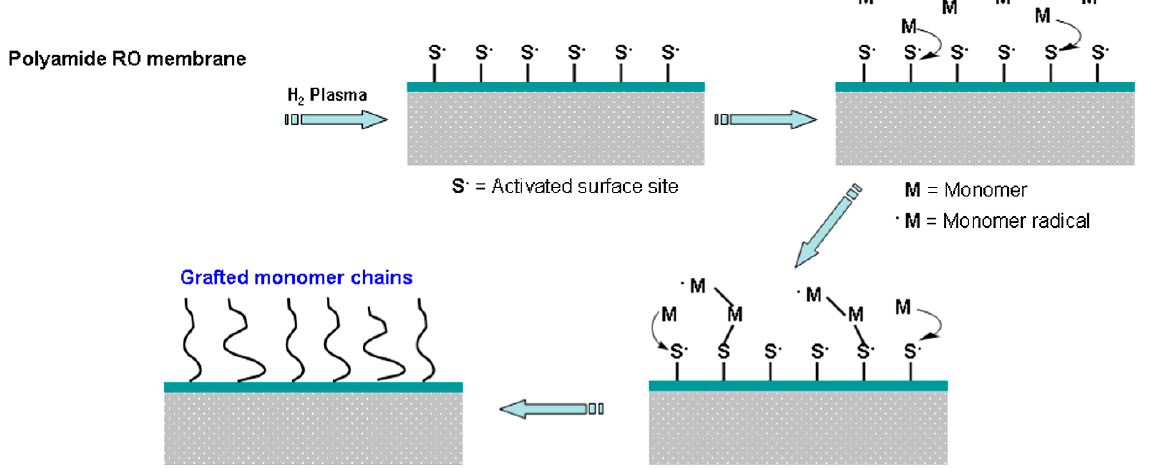
Figure 8. Polyamide RO membrane modification via plasma-induced surface activation followed by surface graft polymerization [283], with permission from Elsevier, 2012.